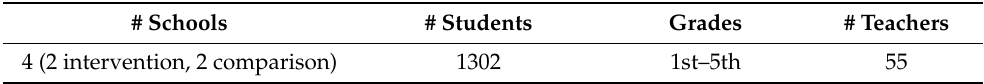
Table 1. Healthy Schoolhouse 2.0 participants: Student